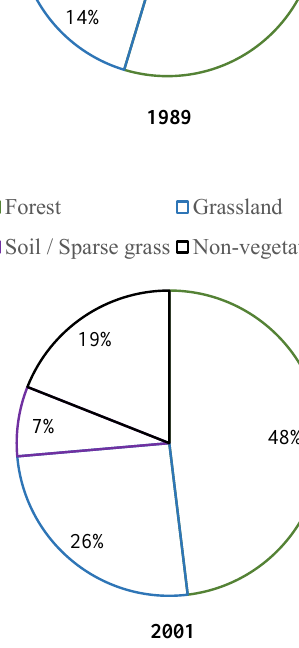
Figure 4 The proportion of each land cover in 1989 and